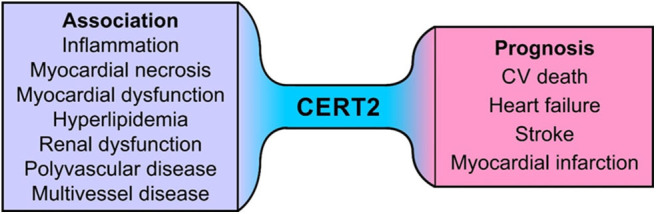
Association of CERT2 with pathophysiological processes and cardiovascular outcomes.